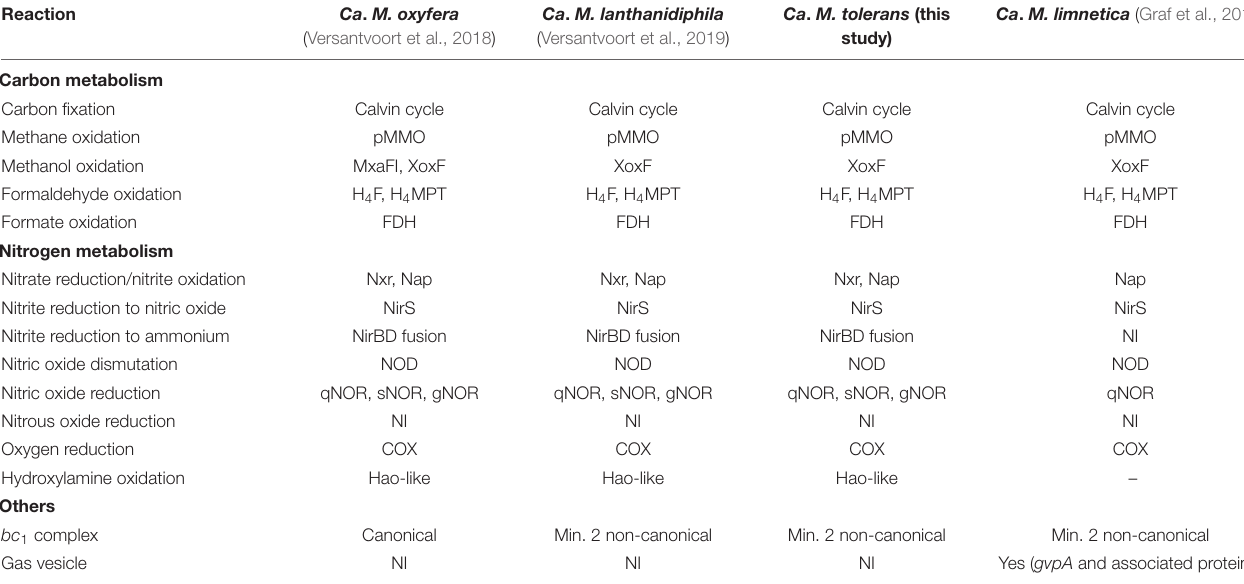
TABLE 1 | Comparison of functional genes and pathways in selected Ca. Methylomirabilis species from this and other studies.